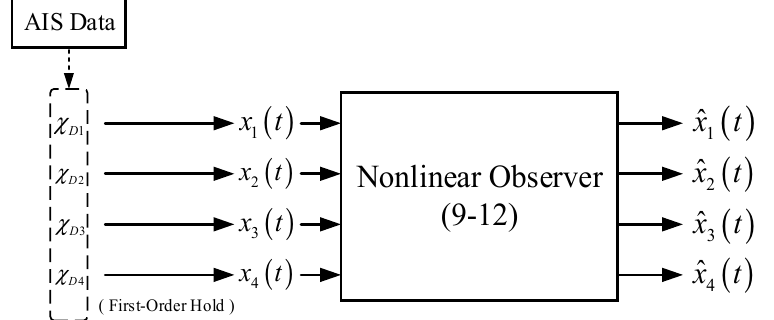
Figure 3. Estimating based on the nonlinear observer design [27].